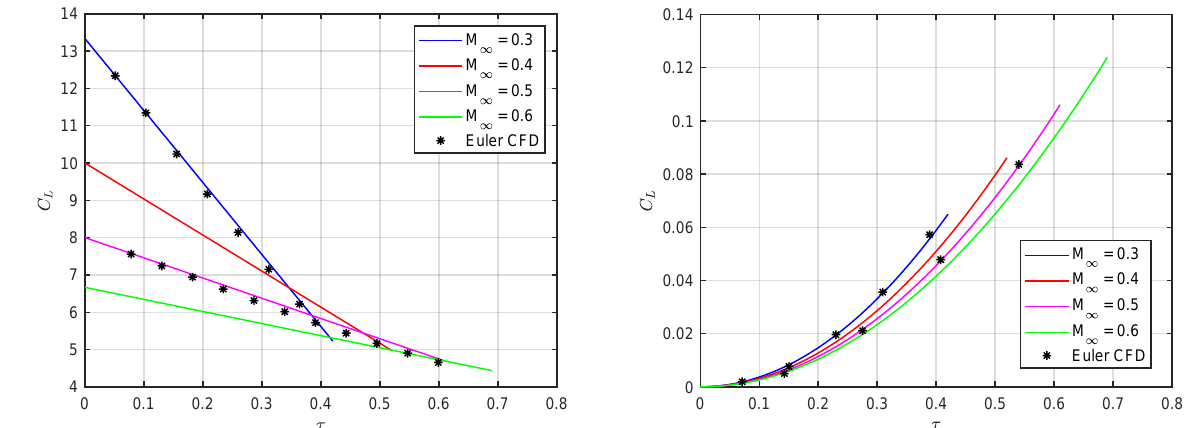
Figure 13. The incipient indicial lift for rectangular swept wing in compressible flow: AOA ( left ) and SEG ( right ), with η = 8 and Λ = 30 ◦ .